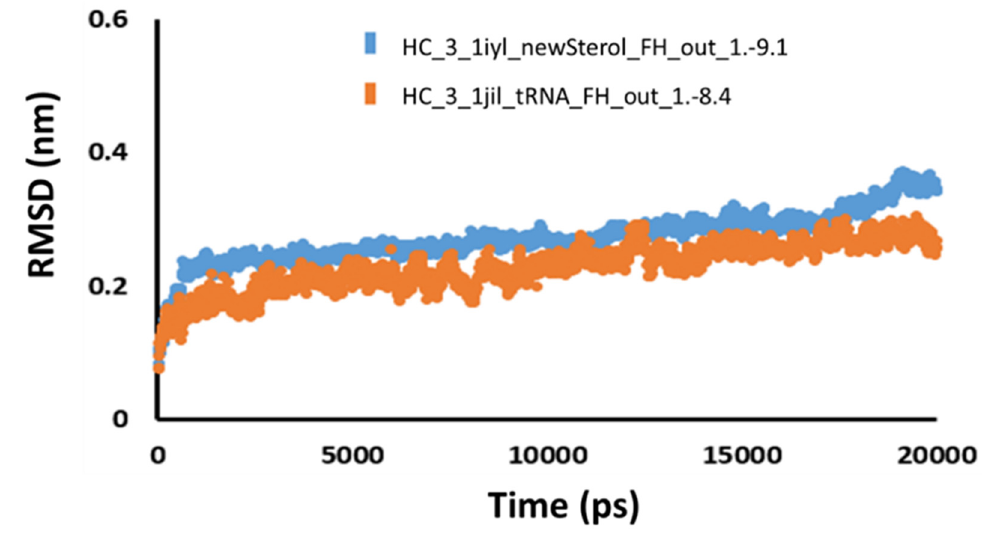
Figure 11. Root-mean-square deviation (RMSD) plot of both backbone proteins in simulated complex system with compound 3.